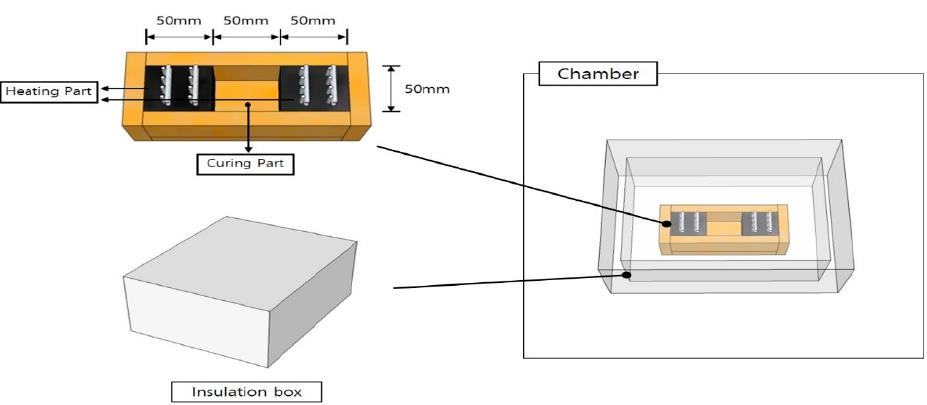
Figure 1. Test mold of the cementitious composites specimens.